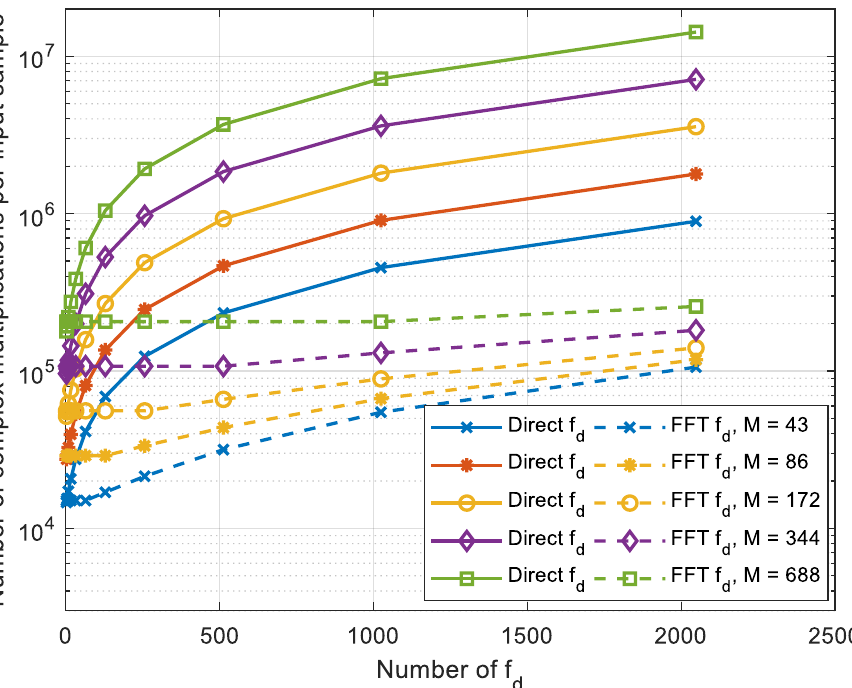
Figure 10. Dependence of the number of complex multiplications on the number of possible values f d for a different number of splits M of the original signal at N s =